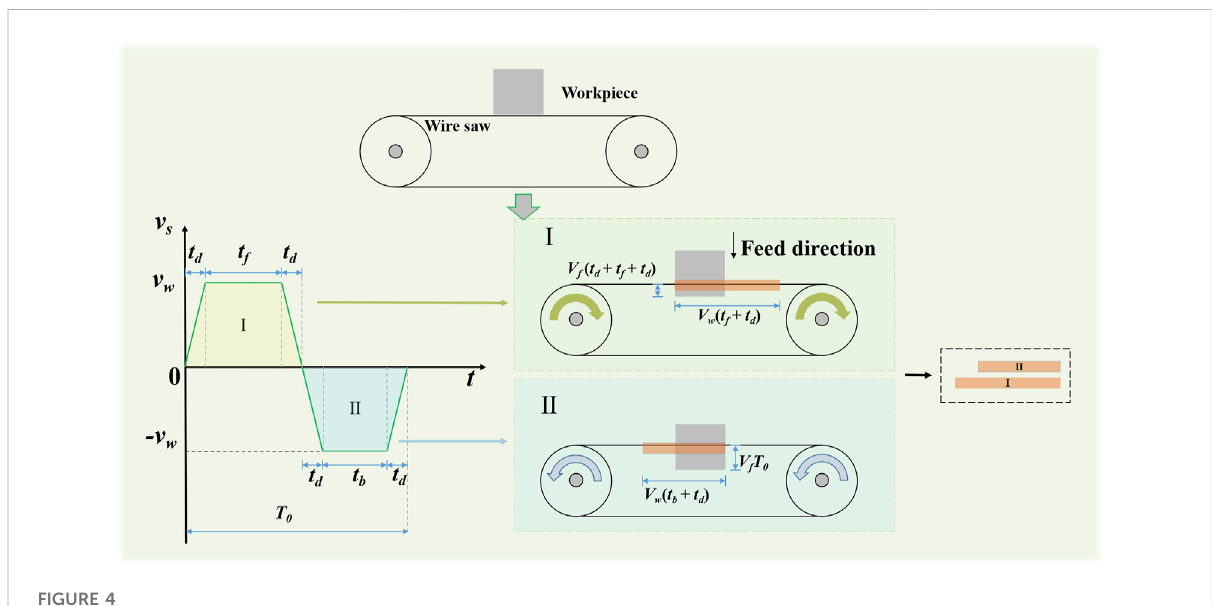
FIGURE 4 Wire movement and wear distribution of wire saw in one reciprocating